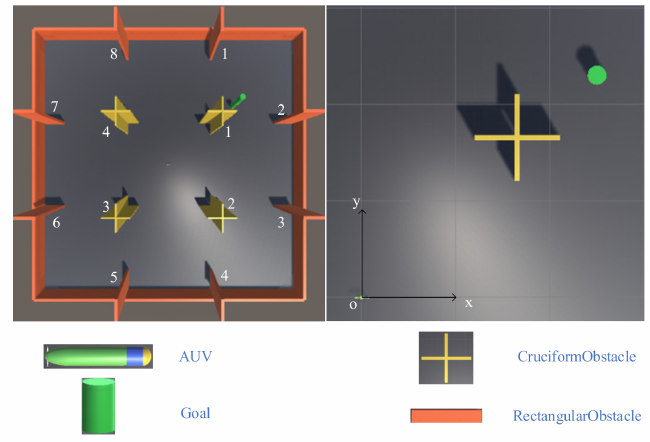
Figure 7. Experimental environment. Table 5. Position and collision size of each element in the environment.